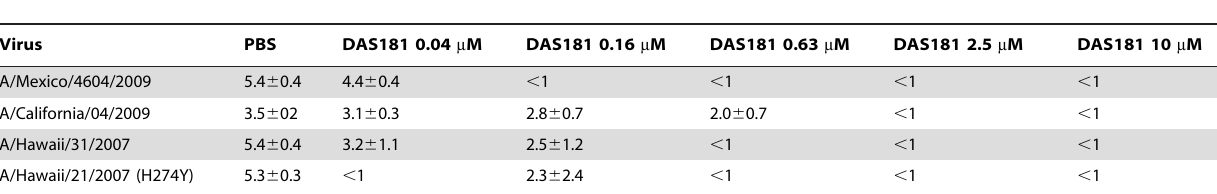
Table 2. DAS181 inhibits pandemic IFV A(H1N1): Viral Yield in MDCK culture (log10 infectious particles per 100 m l).